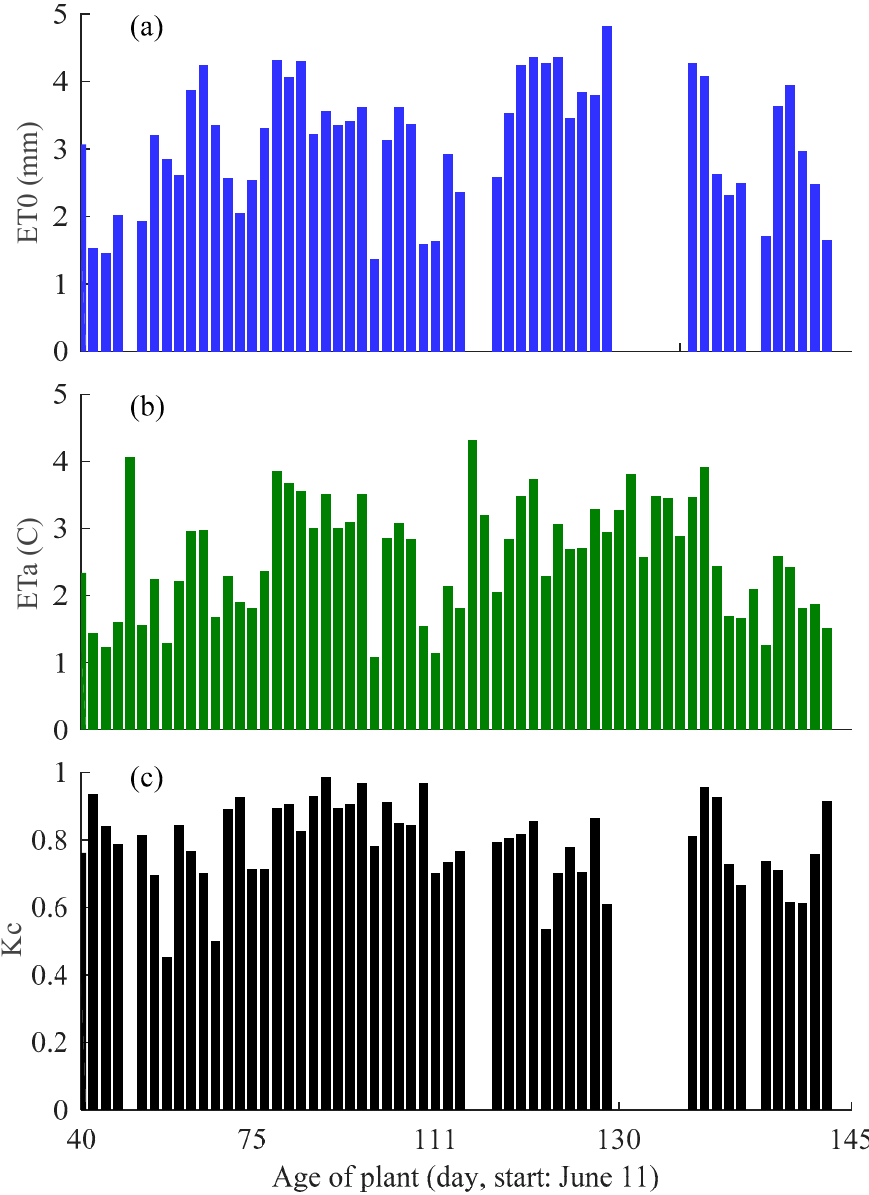
Figure 7. ( a ) Potential evapotranspiration (ET o , calculated by the Penman-Monteith method), ( b ) actual evapotranspiration (ET a , calculated from experimental data and water balance) and ( c )